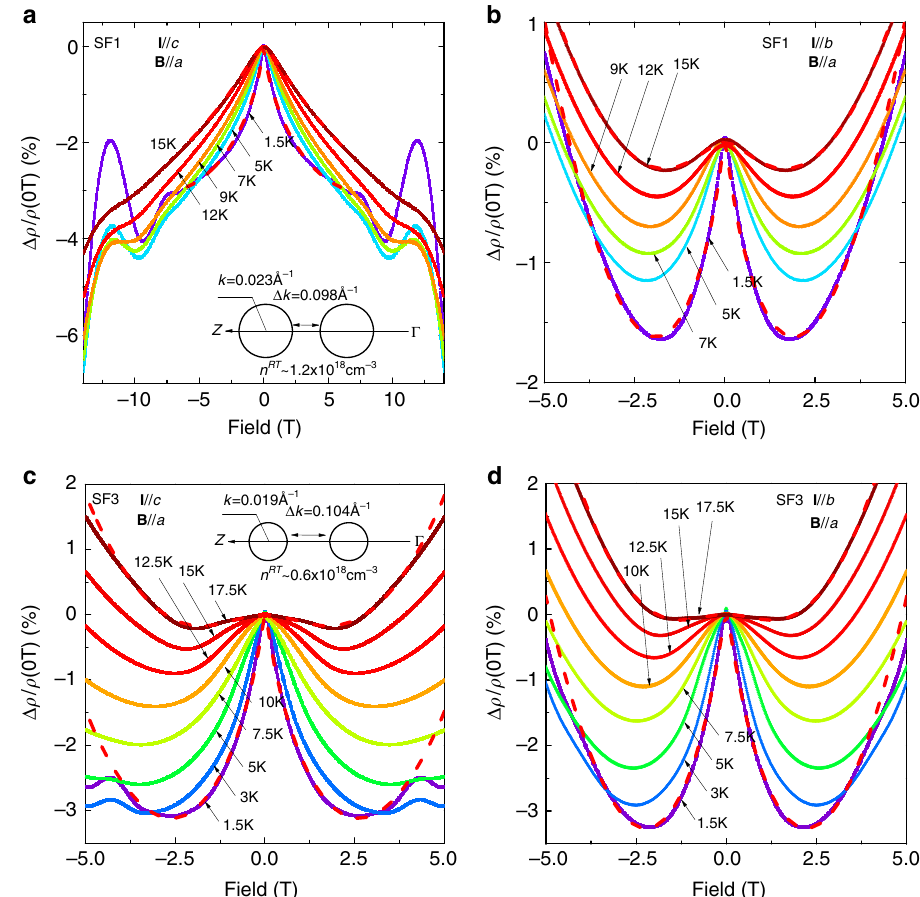
Fig. 3 Doping-dependent highly anisotropic weak localisation in p-SnSe. a , b NMR in SF1-SnSe for I || c and I || b , respectively, when the positive WL correction to resistivity is suppressed by external fi eld. The red-dash lines are the fi tting results using the WL model in the main text, which explains the evolution of low- fi eld NMR very well by T -dependent l ϕ . Strikingly, the NMR growth of SF1-SnSe for I || c is non-saturating up to 14 T, while NMR for I || b dwindles as a function of T and is only dominant below 2 T. The low- fi eld NMR in SF3-SnSe becomes less anisotropic, however, the overall WL correction to resistivity is stronger in these samples (see c , d ). The insets of a , c show the sketches of the FS cross-sections for SF1- and SF3-SnSe, respectively. For I || c , intervalley scattering assisted by the in-plane dipole fi eld along the c -axis gets enhanced, when the two pudding-mould valleys become closer by p-doping. Note that the SnSe 2 phase segregation may lead to non-uniform doping in p-SnSe, making the two pudding-mould valleys even closer in localised